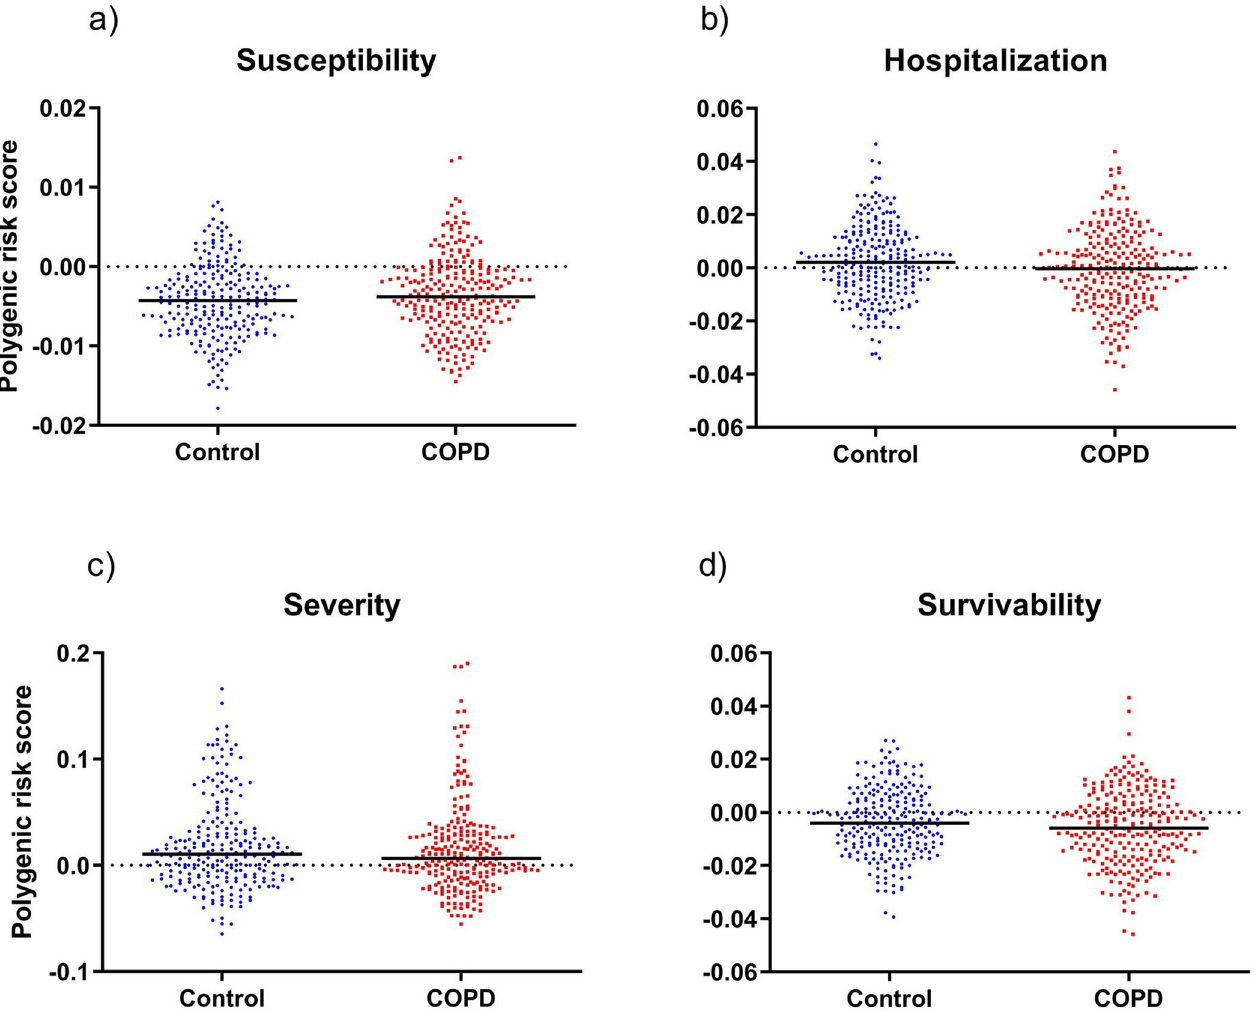
Fig 3. Polygenic risk score for susceptibility to COVID-19 infection (a), hospitalization due to COVID-19 infection (b), severe COVID-19 with respiratory failure (c) and survivability to COVID-19 infection (d). Results shown as scatter dot plots with median represented. No significant differences were found between the polygenic risk scores of COPD and control groups for any of the phenotypes tested; a) p-value = 0.05; b) p-value = 0.03; c) p-value = 0.38; d) p- value =